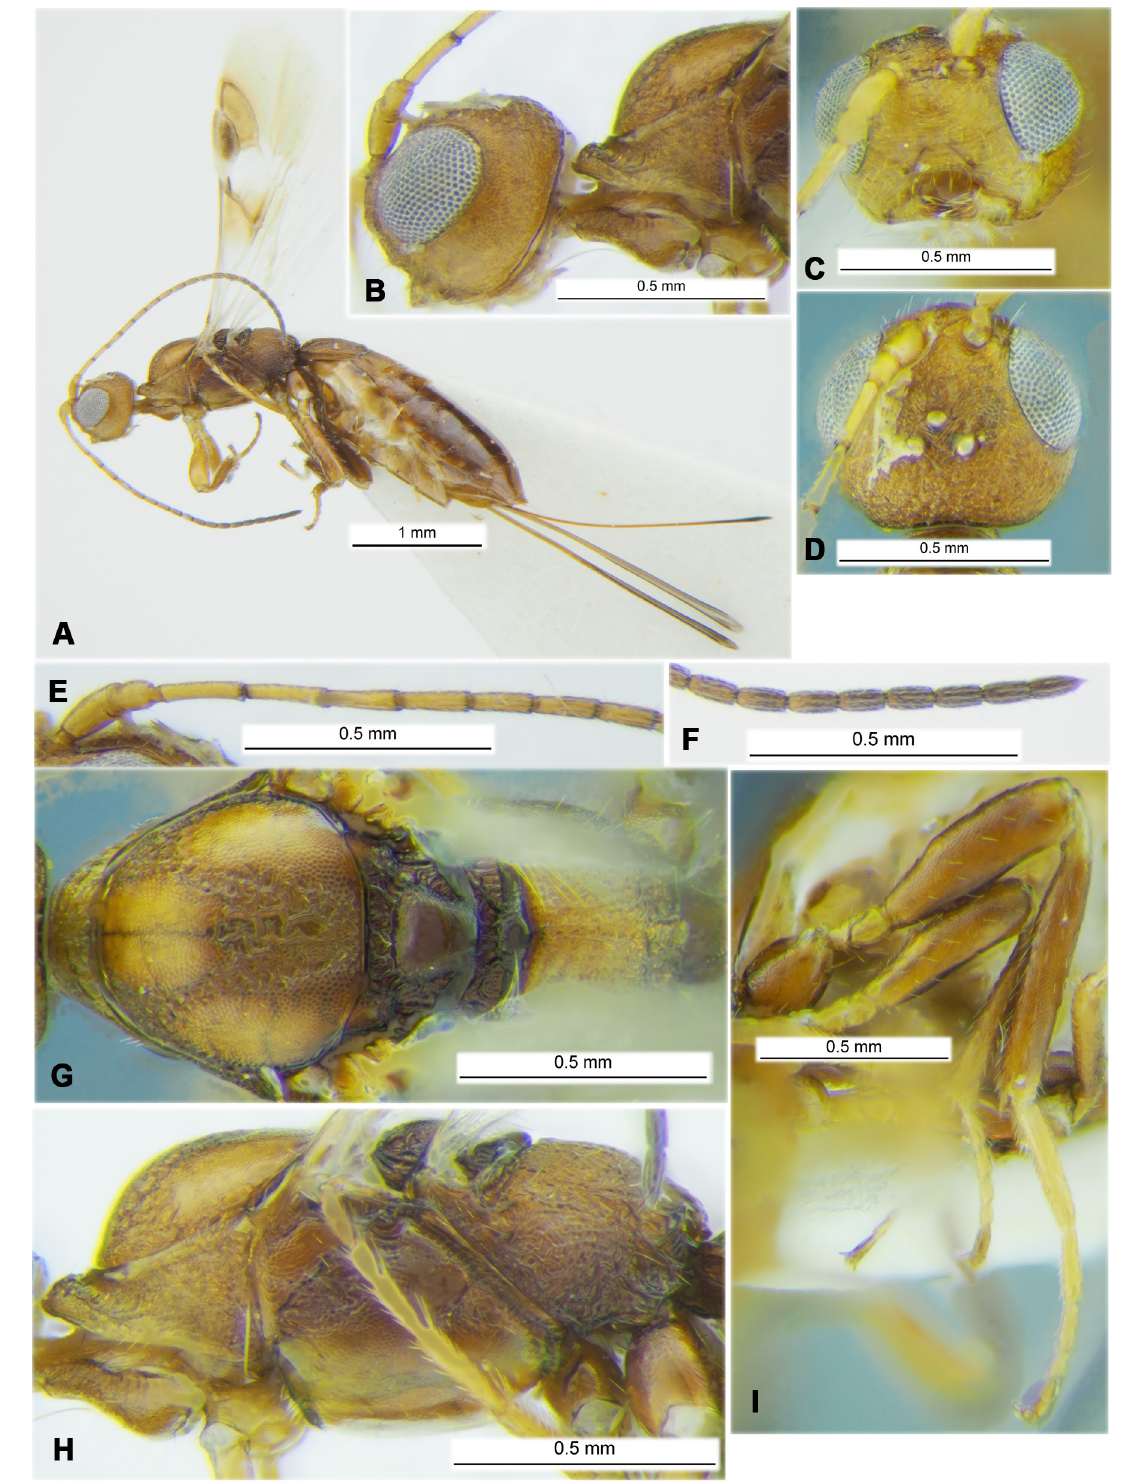
Fig. 28. Hecabalodes maculatus Belokobylskij sp. nov., holotype, ♀ (RMNH). A . Habitus, lateral view. B . Head and anterior part of mesosoma, lateral view. C . Head, front view. D . Head, dorsal view. E . Basal segments of antenna. F . Apical segments of antenna. G . Mesosoma, dorsal view. H . Head and mesosoma, lateral view. I . Hind